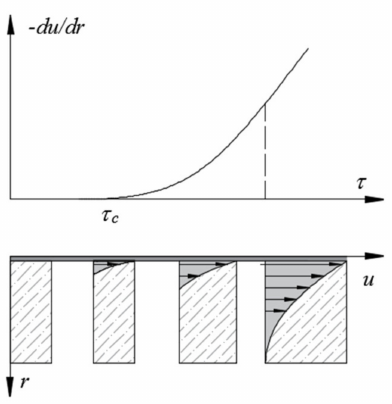
Figure 1. Soil phase